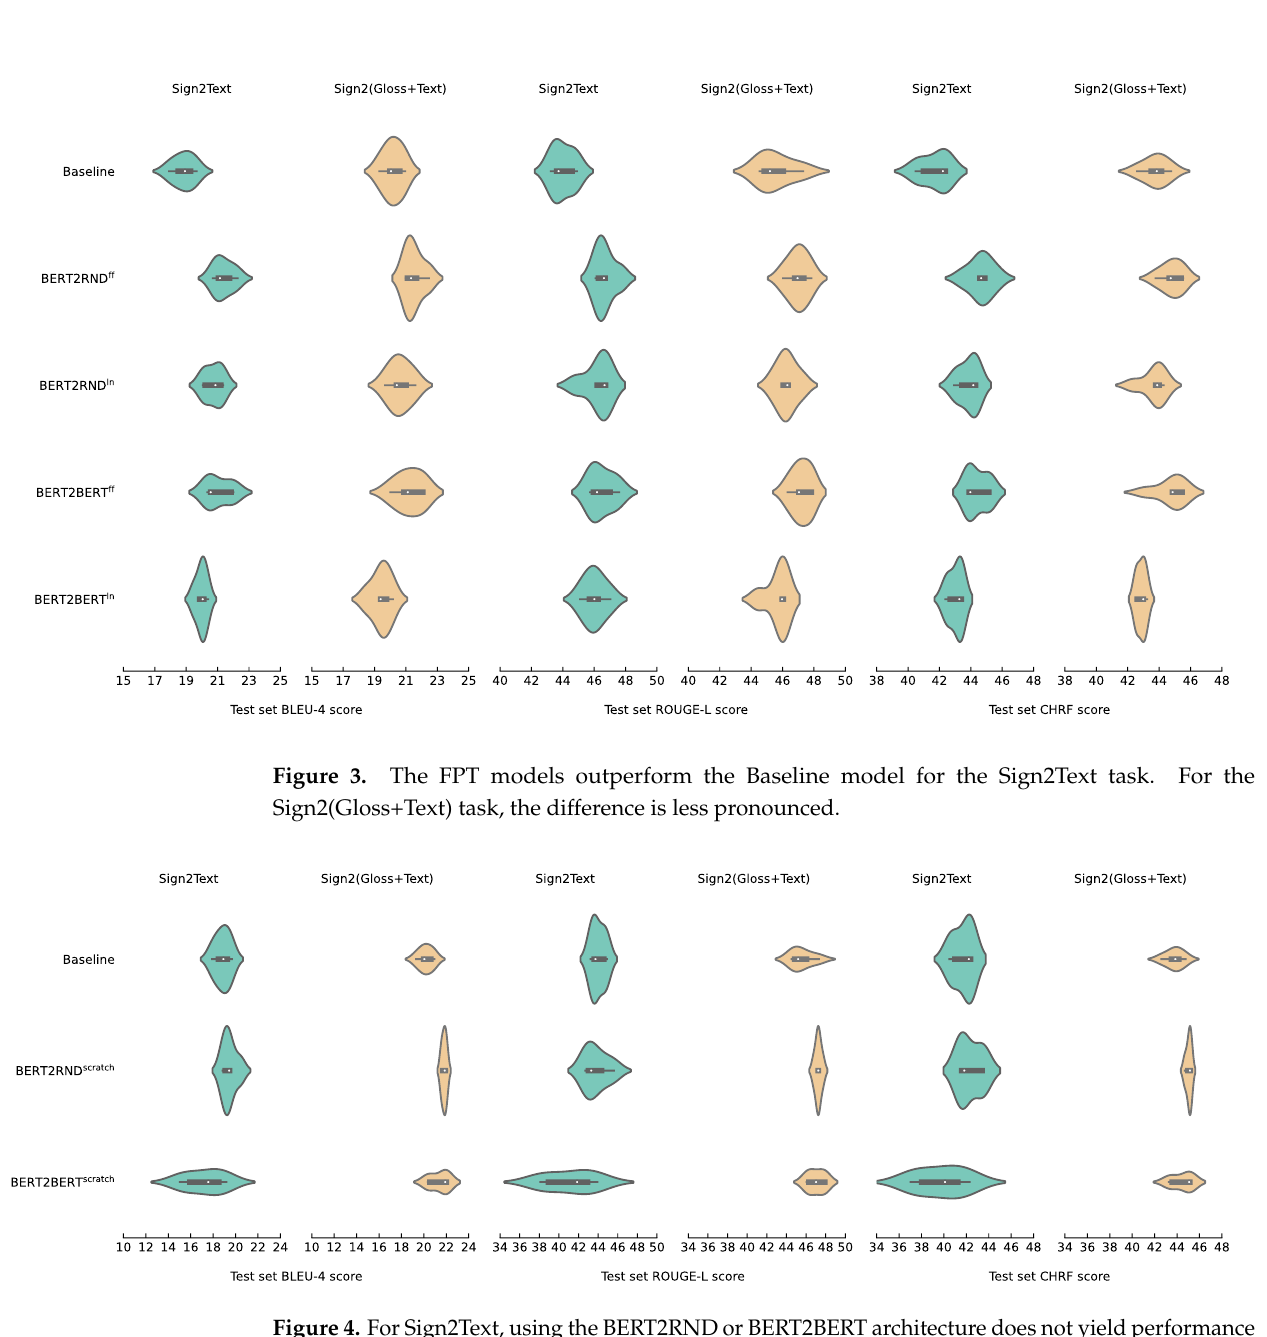
Figure 4. For Sign2Text, using the BERT2RND or BERT2BERT architecture does not yield performance gains. For Sign2(Gloss+Text), we observe slight performance gains compared to the Baseline